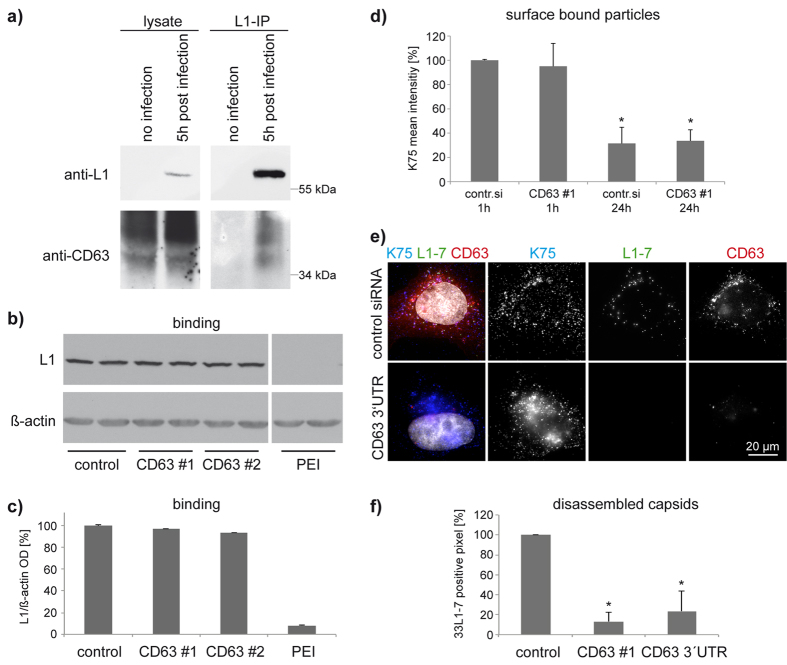
CD63 associates with L1 and is involved in HPV16 post-uncoating processing but not in cell surface binding or virus endocytosis.(a) CD63 is coprecipitated by L1 pAb K75 immunoprecipitation (IP) from lysates of HPV16 PsV infected HeLa cells. Expressed (left) and precipitated proteins (right) were detected by Western blotting using L1 mAb 321-F (upper panels) and mAb CD63 (lower panels). (b–d) CD63 knockdown does not affect HPV16 cell binding. (b) HeLa cells were pretreated with CD63 or control siRNA and incubated with HPV16 PsV. Cell-bound PsV were detected in cell lysates by Western blotting (WB) using L1 mAb 312F. Polyethylenimine (PEI) treated cells were used as control for binding deficiency75. (c) Quantification of WB bands shows HPV16 cell surface binding independent of CD63. (d) PsV binding and endocytosis is unaffected by CD63 knockdown. HeLa cells were pretreated as in (b). Cells were incubated with HPV16 PsV as indicated. The amount of surface associated PsV was assessed by flow cytometry using L1 pAb K75. The difference between the amount of surface bound PsV at 1 h and 24 h serves as a measure for endocytosis. Mean fluorescence intensity of cells incubated with PsV for 1 h was adjusted to 100%. (e,f) L1-7 reactivity is reduced after CD63 knockdown. Representative pictures of immunofluorescence with HPV16 L1 pAb K75 (blue), mAb 33L1-7 (green) and CD63 mAb (red) are shown in (e). Hela cells were treated with siRNAs as in (b) and infected for 7 hours. K75 Ab recognises bound and internalized virus particles. 33L1-7 Ab recognises HPV16 epitope only accessible after capsid disassembly. (f) Shows quantification of disassembled viral capsids performed by analysis of L1-7 positive pixels of at least 15 images using ImageJ-script. Shown are the results of three independent experiments using CD63 siRNAs normalized to control siRNA treated cells. *P < 0.05 compared to control.